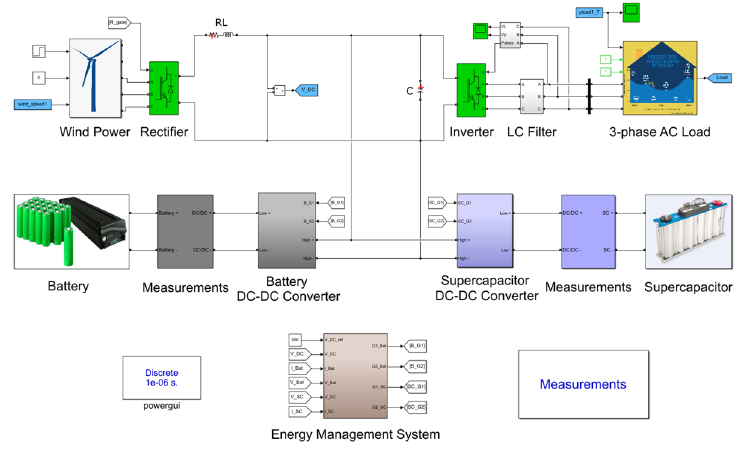
Figure 3. Simulation of the HESS in a household-prosumer system (battery-SC HESS with wind power).